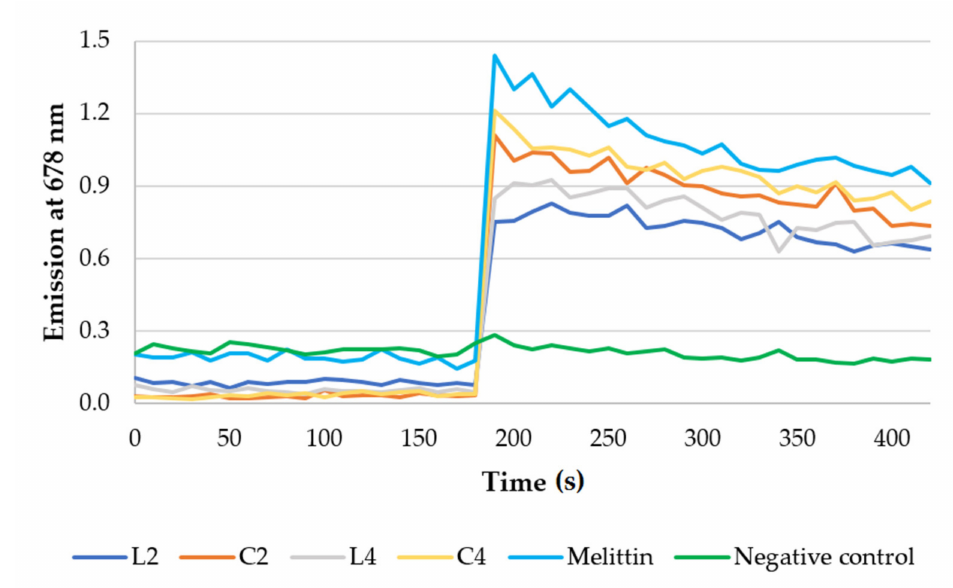
Figure 6. Results of fluorescence measurements of membrane potential-sensitive probe— C. albicans